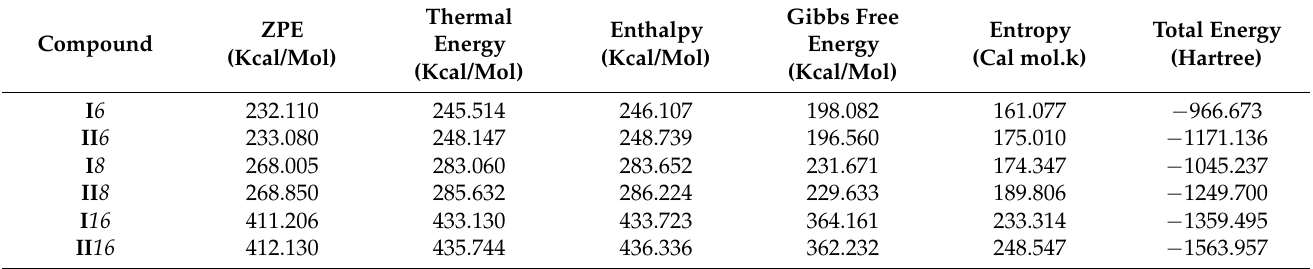
Table 2. DFT calculated thermal parameters using B3LYP/6-311G** method.